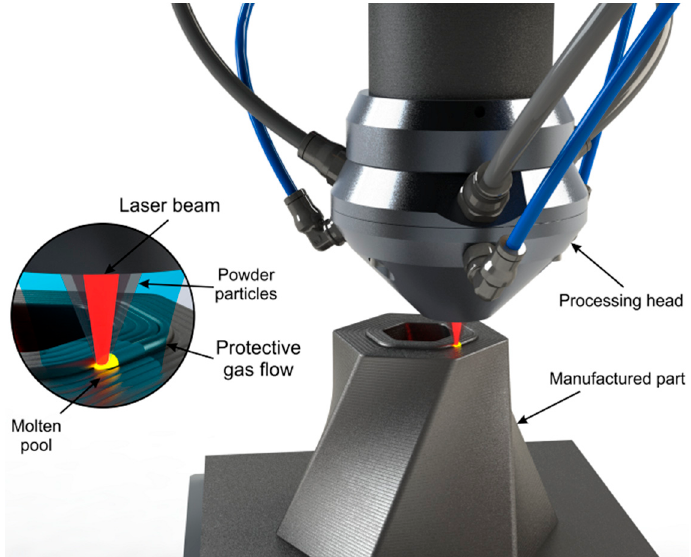
Figure 1. Outline of the LDED (laser-directed energy deposition) technique with coaxial particle injection set-up. Detail of the interaction zone showing the convergence of the laser beam and powder particles into the molten pool under an inert protective atmosphere.